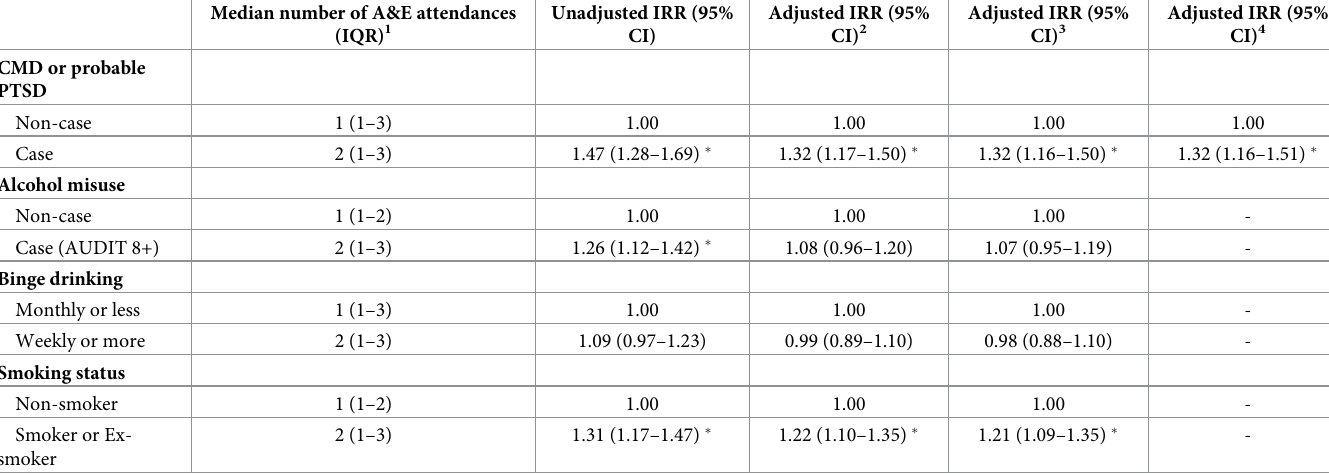
Table 5. Risk factors at phase 2 associated with the number of subsequent attendances to accident and emergency (A&E)